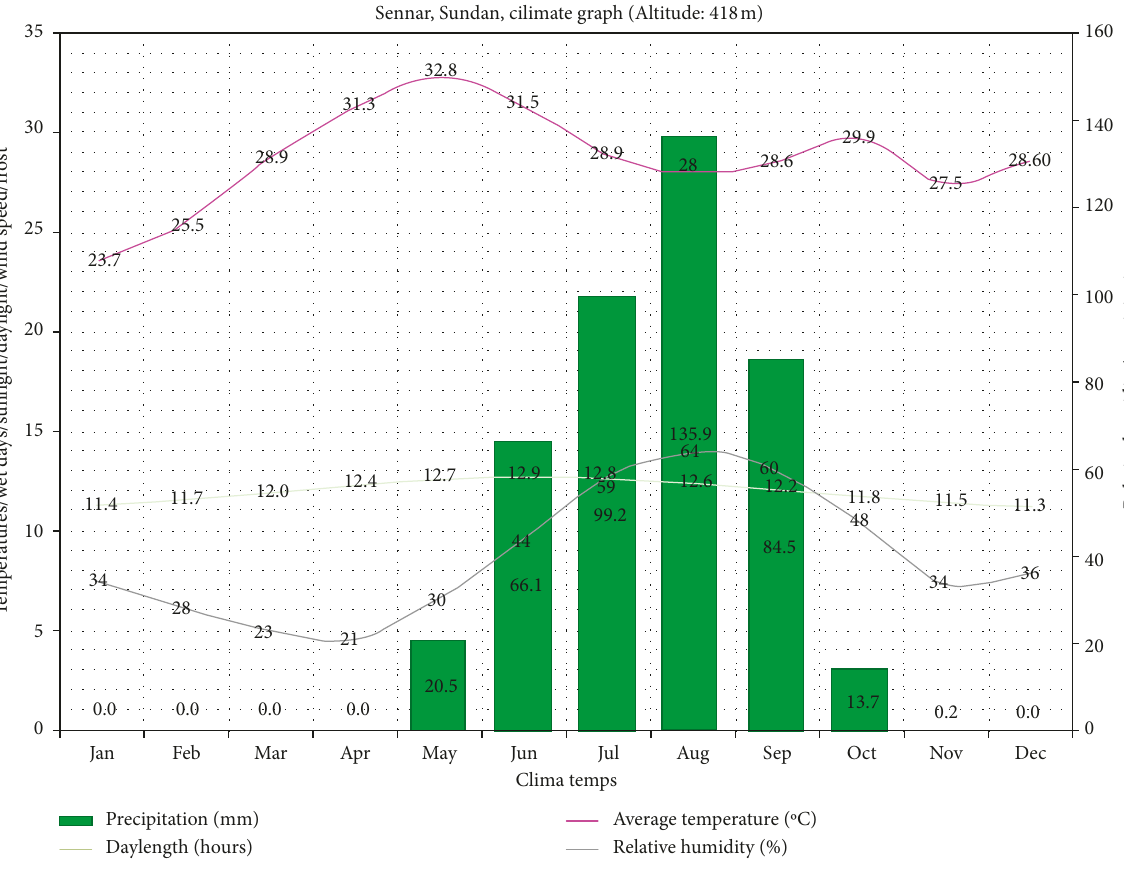
Figure 4: Sennar, Sudan, is at 13 °